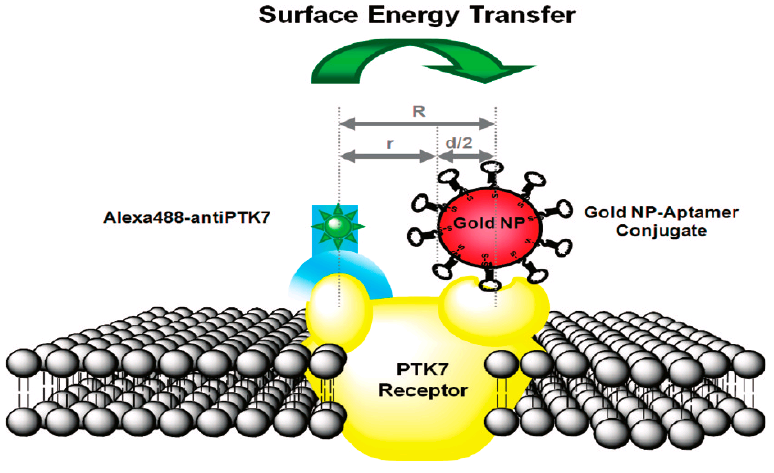
Figure 18. Drawing of a SET nanoruler [86].